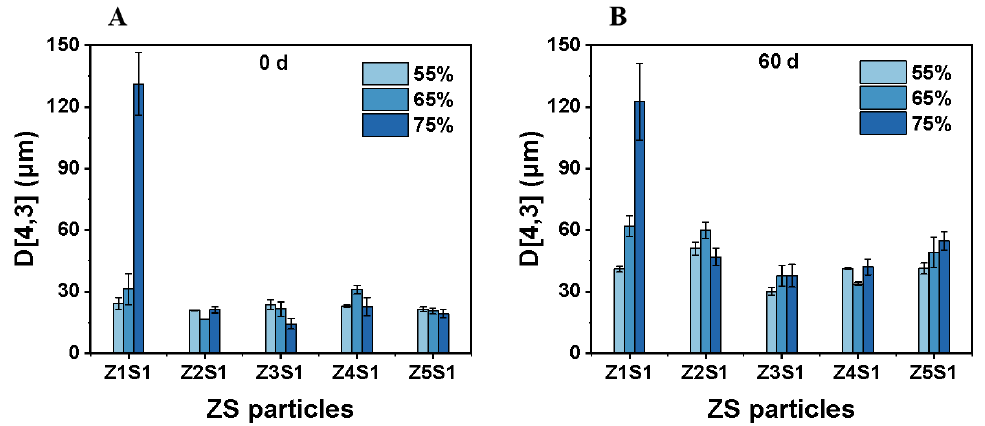
Figure 8. The mean volume diameter of the Pickering emulsions stabilized by ZS particles with different oil part fractions at 0 d ( A ) and 60 d ( B ).